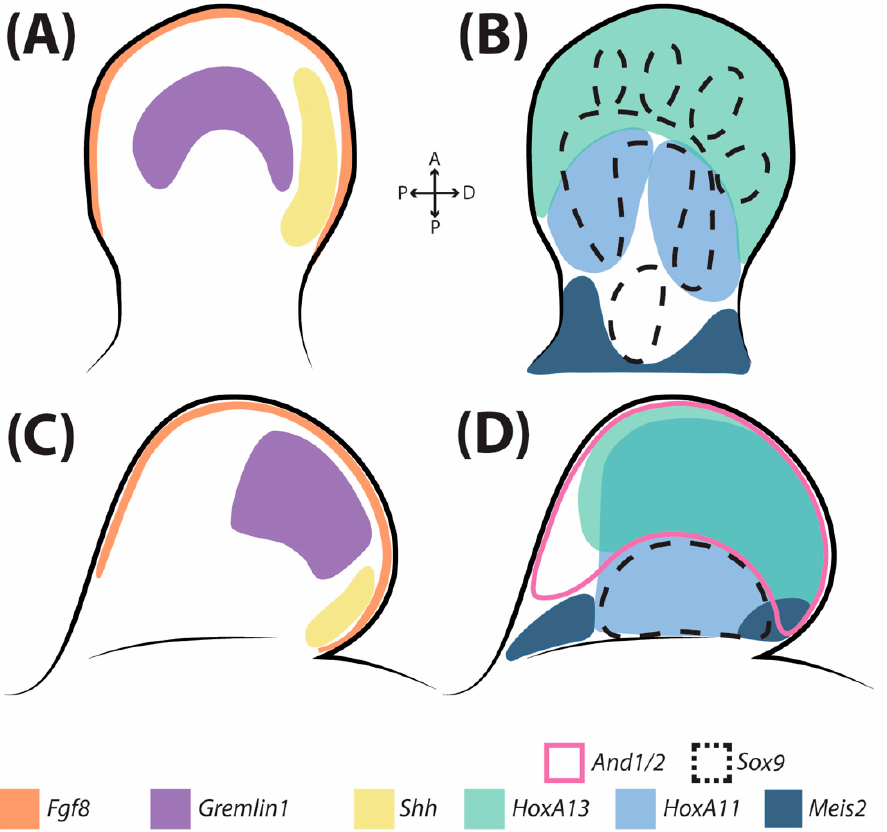
Figure 3. Fins and limbs are patterned by a conserved gene regulatory network (GRN). Representative limb (( A , B ) mouse, Mus musculus ) and fin (( C , D ) paddlefish, Polyodon spathula ) pectoral appendages. ( A , C ) Expression patterns demonstrate conserved aspects of the Shh–Fgf feedback loop, including Shh in the zone of polarizing activity (ZPA), Fgf8 expression in the apical ectodermal ridge (AER), and Gremlin1 in the appendage mesenchyme. ( B , D ) Expression patterns demonstrate conserved aspects of proximo-distal patterning via HoxA network components. Markers for the presumptive stylopod ( Meis2 ), zeugopod ( HoxA11 ), and autopod ( HoxA13 ) are also present in fins, but without the distinct regionalization present in limbs. Expression of Sox9 and And1/2 marks the presumptive endoskeleton and dermatoskeleton regions, respectively. Illustrations not to scale; expression patterns adapted from References [21,22].